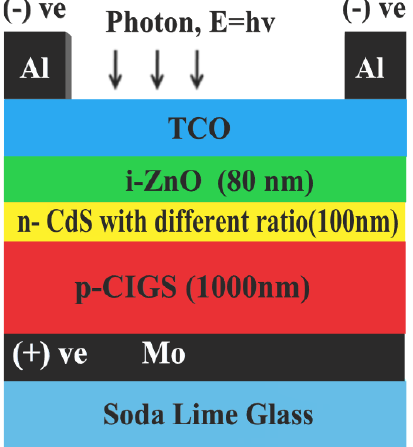
Figure 2. Device configuration for CIGS solar cell.